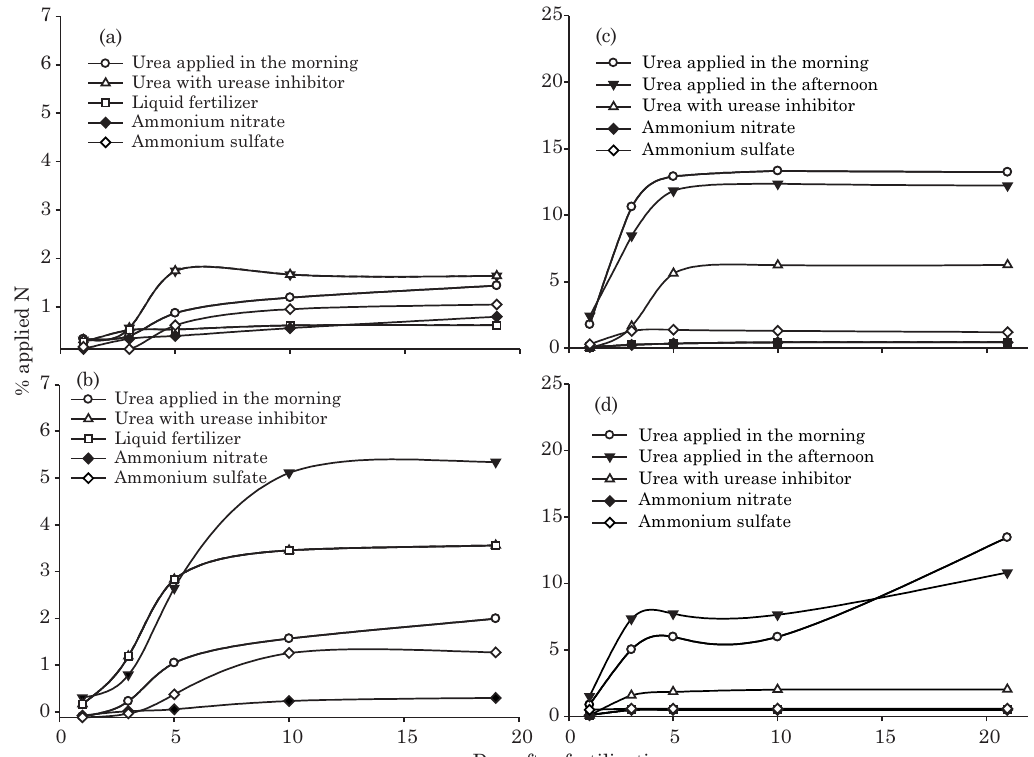
Figure 3. Percentage of applied N lost through ammonia volatilization from different N sources applied in winter [wheat; growing seasons 2009 (a) and 2010 (b)] and summer [maize; growing seasons 2009/10 (c) and 2010/11 (d)], in the south-central region of Paraná. Note: the scale of the y-axis of figures representing winter (a, b) and summer (c, d) are